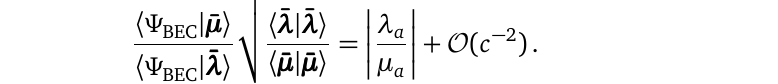
Figure 5: An example of a type I excitation. Dots indicate Bethe numbers that are the same. We see that ννν differs from ¯ λλλ by the replacement − I from ννν by replacing I